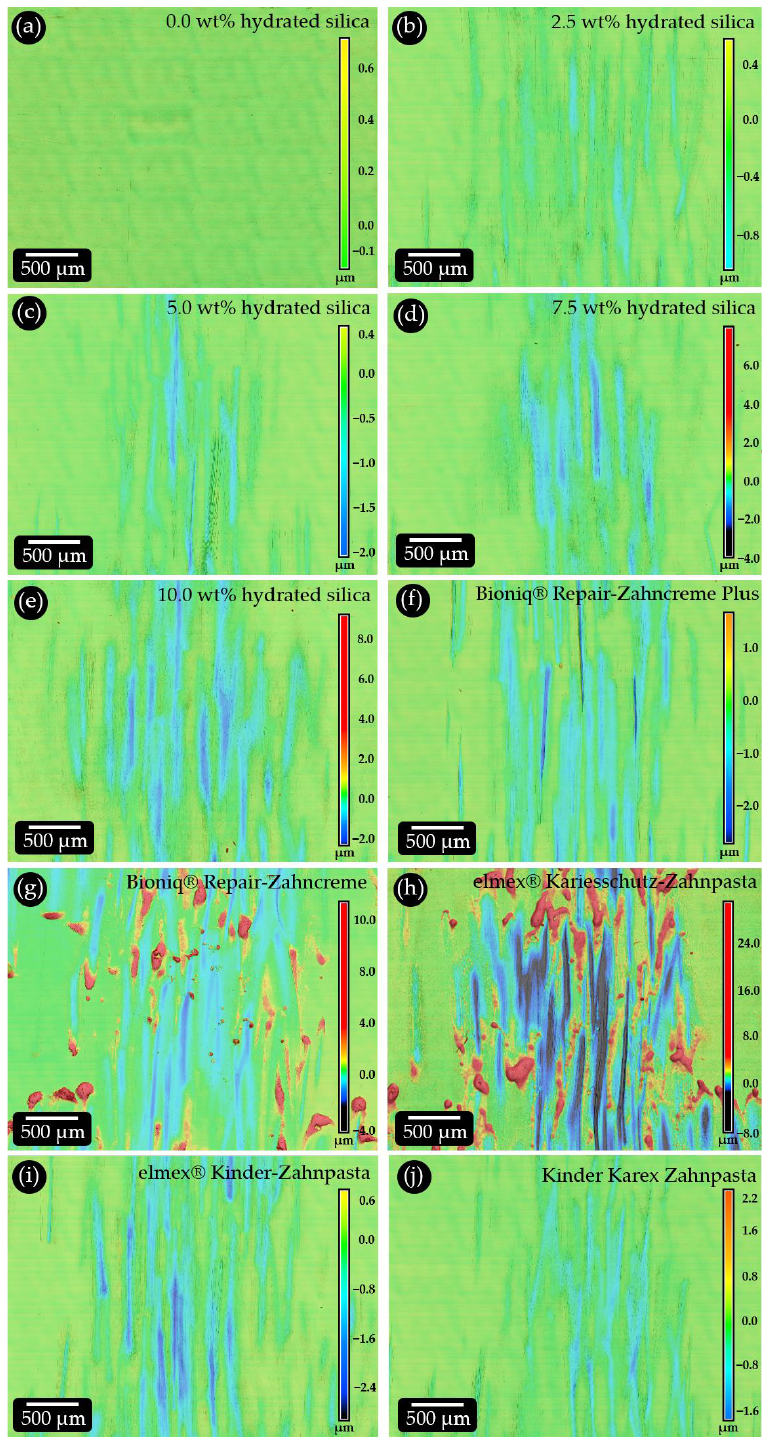
Figure 5. Representative roughness maps obtained by profilometric analysis of the toothbrush sim- ulator abrasion experiments. ( a ) Reference brushed with distilled water. ( b – e ) Model toothpaste formulations with ( b ) 2.5 wt%, ( c ) 5 wt%, ( d ) 7.5 wt% and ( e ) 10 wt% of abrasive hydrated silica parti- cles. ( f – j ) Samples cleaned with commercially available toothpastes. ( f ) Bioniq ® Repair-Zahncreme Plus, ( g ) Bioniq ® Repair-Zahncreme, ( h ) elmex ® Kariesschutz Zahnpasta, ( i ) elmex ® Kinderzahnpasta and ( i ) Kinder Karex Zahnpasta. Since the surface scratch depths varied significantly between the different tested formulations, each map was individually color-coded (see right side of each